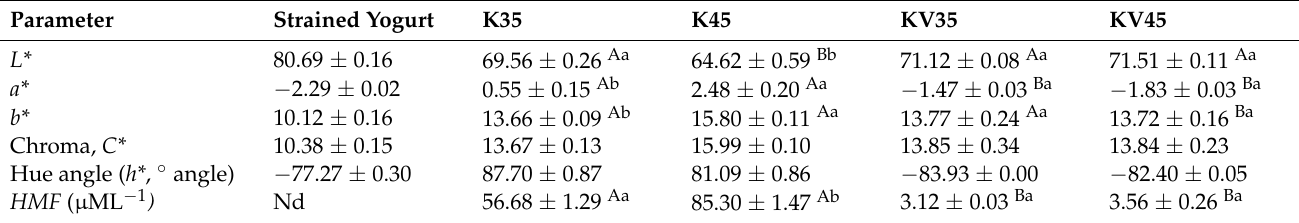
Table 5. Color characteristics of strained yogurt and Kurut